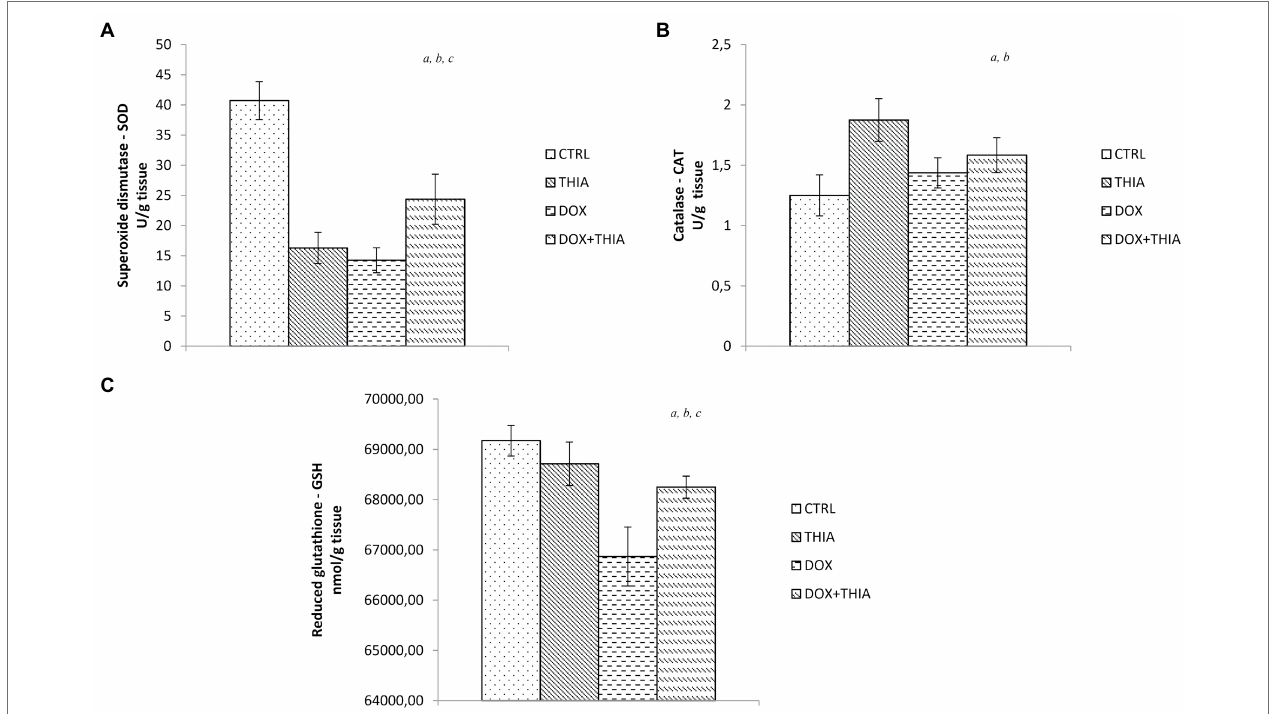
FIGURE 2 | Changes in the heart tissue antioxidative parameters of superoxide dismutase (SOD; A ), catalase (CAT; B ), and glutathione (GSH; C ) in the CTRL, THIA, DOX, and DOX + THIA groups. Values are presented as means ± SEM. a p < 0.05 compared with the normal CTRL group; b p < 0.05 compared with the THIA group; c p < 0.05 compared with the DOX group; and d p < 0.05 compared with the DOX + THIA